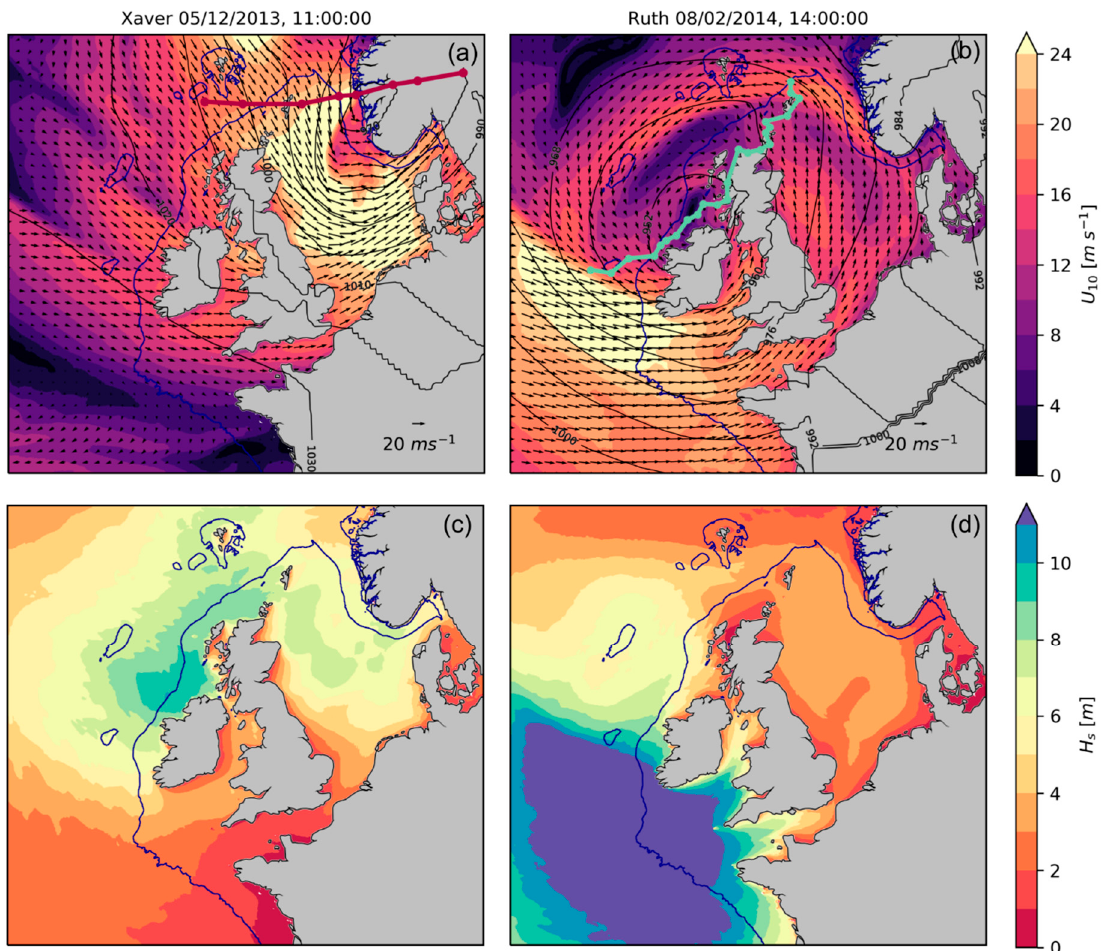
Figure 3. Snapshots of ( a , b ) wind speed ( U 10 ) and ( c , d ) significant wave height ( H s ) during storms Xaver and Ruth. Storm snapshots for U 10 include wind direction vectors, mean sea level pressure contours and storm tracks. Winds are extracted as sea points only from WWIII system component – UKW4g-ST4 experiment. To facilitate visualization, wind vectors are plotted every 35 grid points. Pressure contours are sourced from the global pressure forcing conditions. The 200-m isobath (solid blue contour) is included to indicate the continental shelf limit.